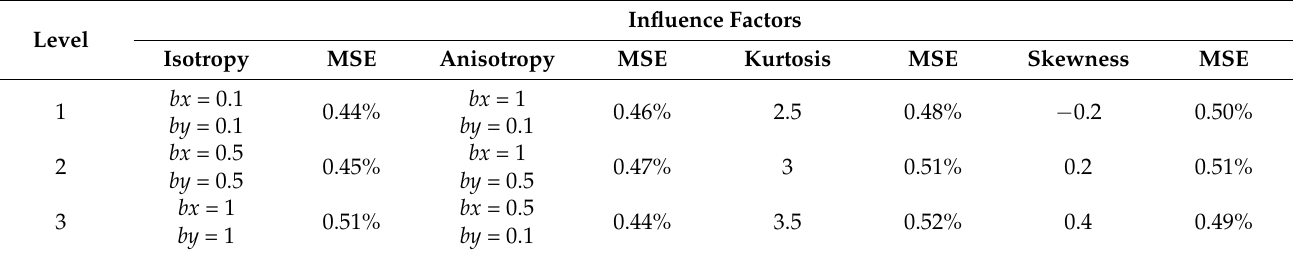
Figure 10. Rough surface and reference plane reconstructed after filtering: ( a ) reference plane; ( b ) reconstructed rough surface. Table 1. MSE of reference plane at different rough surfaces.